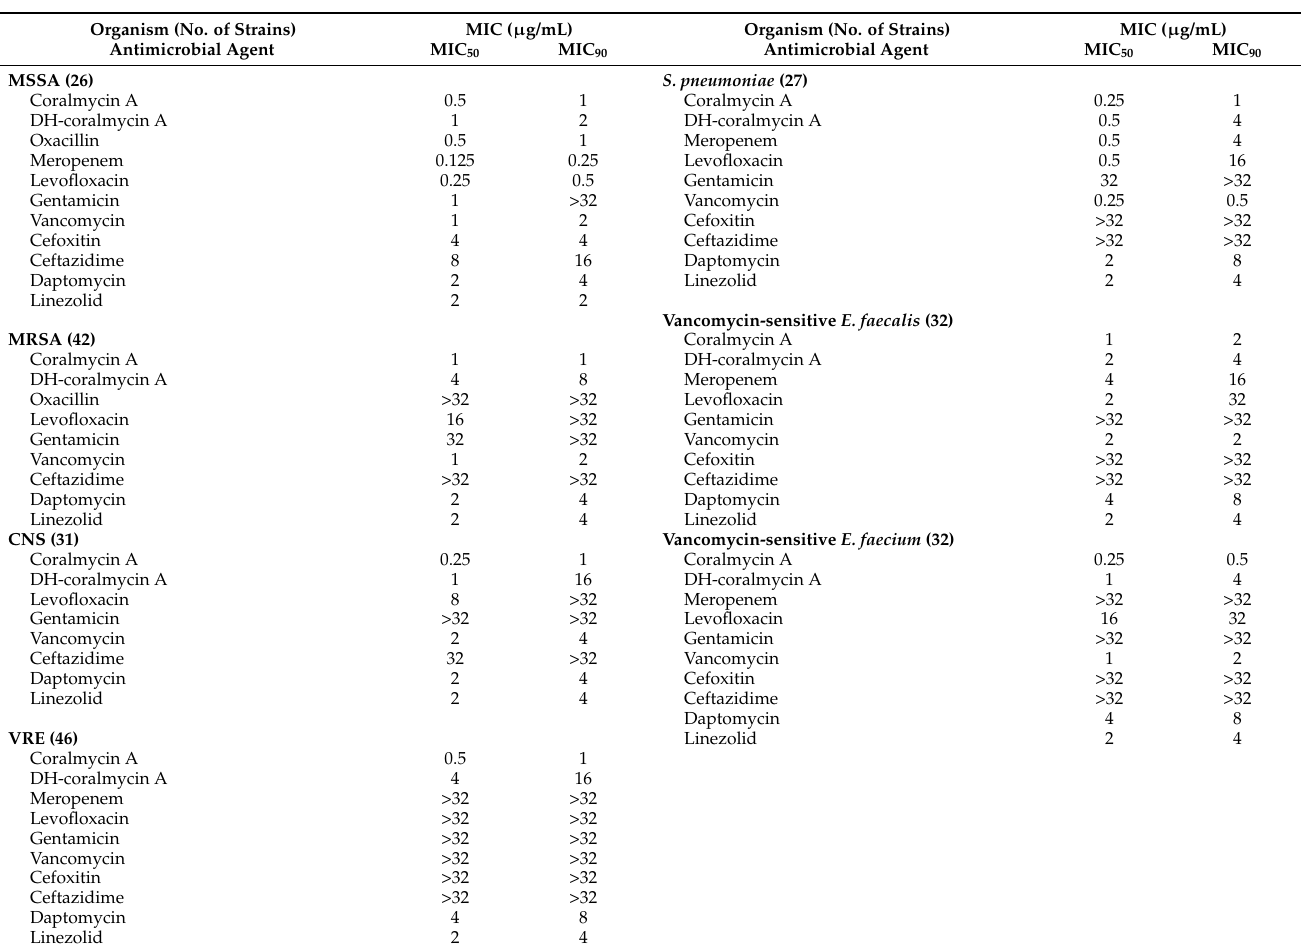
Table 1. Comparison of the in vitro activity of coralmycins with that of comparable drugs against clinical Gram-positive bacterial